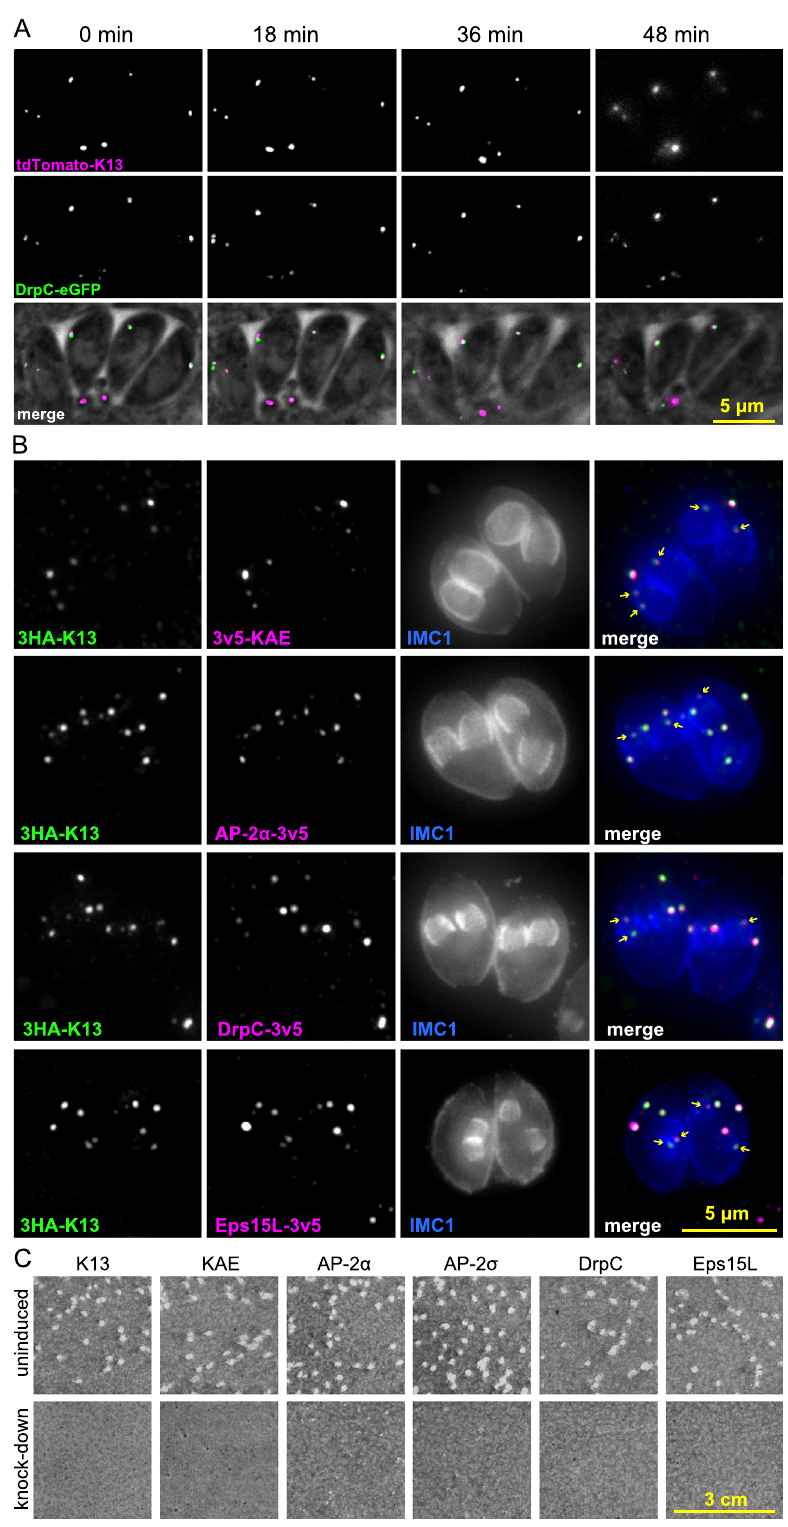
Fig. 4 | The K13 complex is stable over time, is assembled early in IMC forma- tionduringcellreplication,andisrequiredforparasitelyticcycleprogression. A Live-celltime-lapsesequenceoffourparasitesinahostvacuoleshowingthatK13 and DrpC locations are stable over time. B Wide- fi eld fl uorescence images of cells fi xedduringtheformationofdaughtercellsthatareevidentbyinternalIMC1(blue)